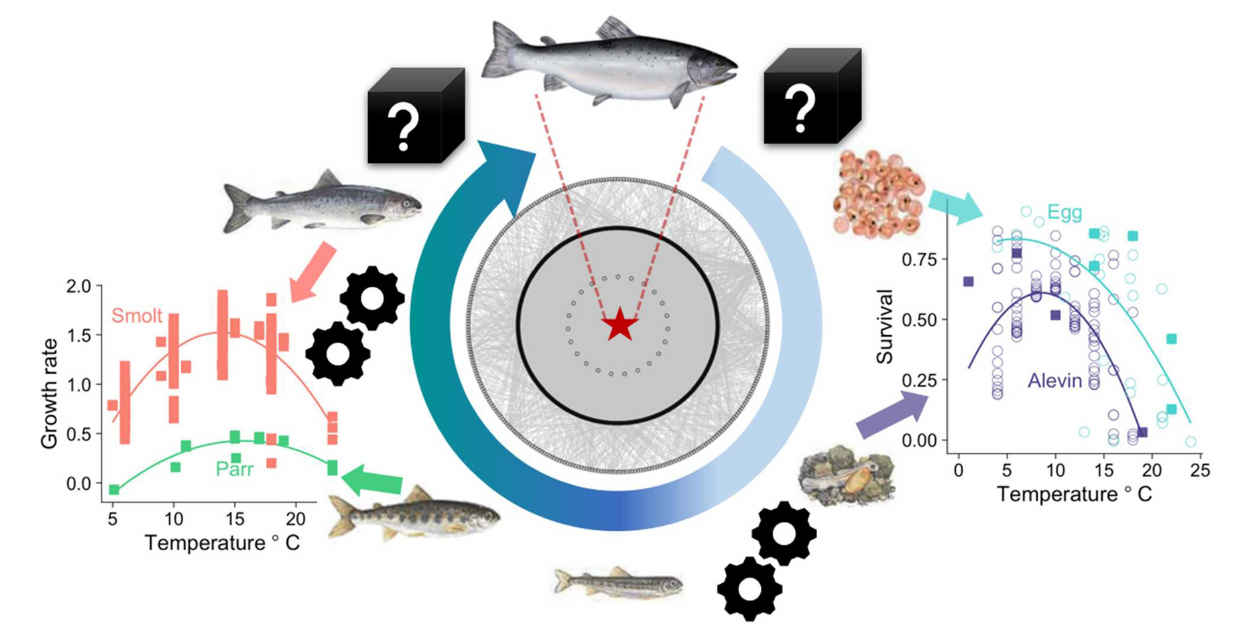
FIGURE 1 | Feeding interactions and gaps in our knowledge across the life cycle in both the marine and freshwater environment need resolving to understand population drivers for future management of Atlantic salmon. Model parameters can relate to different stages the life cycle with thermal performance curves showing the relationship between temperature and vital rates (survival and growth) across salmonids and how these may vary at each life stage (data points for Atlantic salmon are shown as solid squares). The central graphic shows the Northeast Atlantic marine food web, arranged with salmon in the center (blue star) and with species that are one, two, or three trophic links away arranged in each subsequent ring. No species in this complex food web is more than three trophic links away from salmon, highlighting the importance of the surrounding ecosystem for understanding salmon population dynamics. There are still some black boxes in our understanding of how pressures on some life stages (e.g., development of eggs in the river, survival at sea) affect population dynamics. The life cycle also presents numerous opportunities for management interventions, including egg planting, construction of salmon ladders, and altering catch-and-release quotas of returning